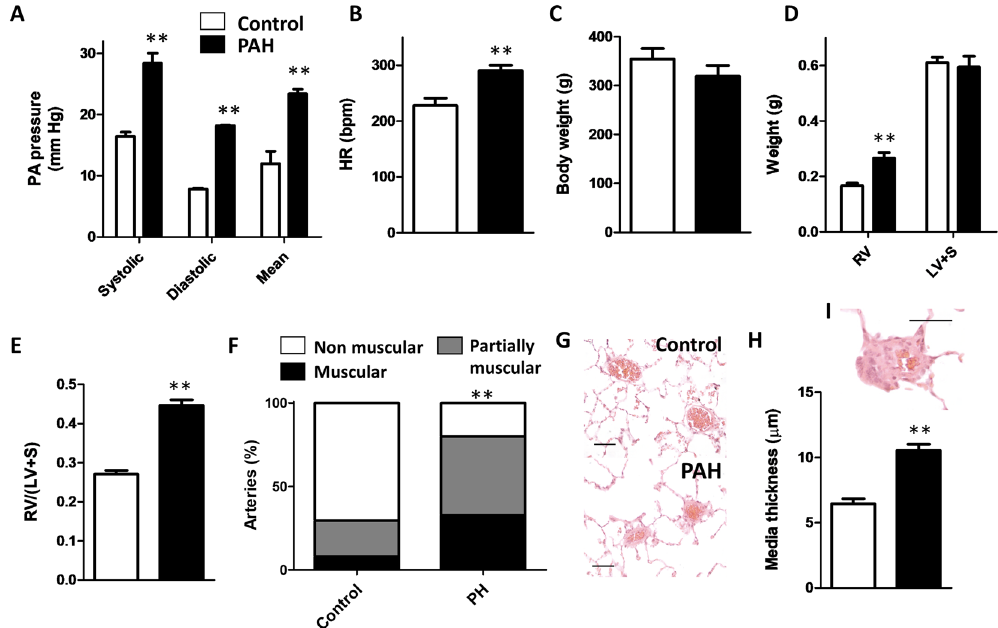
Figure 1. Hemodynamic and histological changes. ( A ) Systolic, diastolic and mean PAP, ( B ) Heart rate, ( C ) Body weight, ( D ) RV and LV + S weight, ( E ) Fulton index [RV/(LV + S)] and ( F ) percentage of arterial muscularization. ( G ) Typical hematoxilin-eosin staining of arterial sections (scale bar 50 µ m), ( H ) Medial thickness, ( I ) An early obliterated lesion (scale bar 50 µ m). Results are means ± s.e.m. of 4 animals, ** p < 0.05 versus control (Students’ t test for panels A–E and Square Chi test for panel